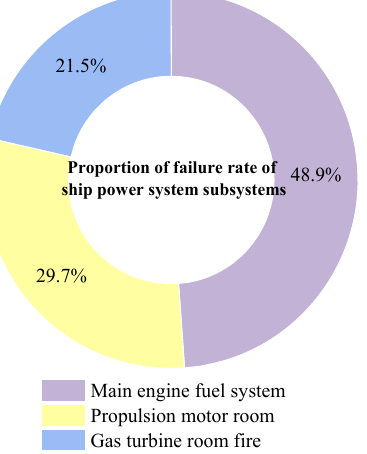
Figure 7. Proportion of annual fire frequencies of a ship power system’s subsystems.